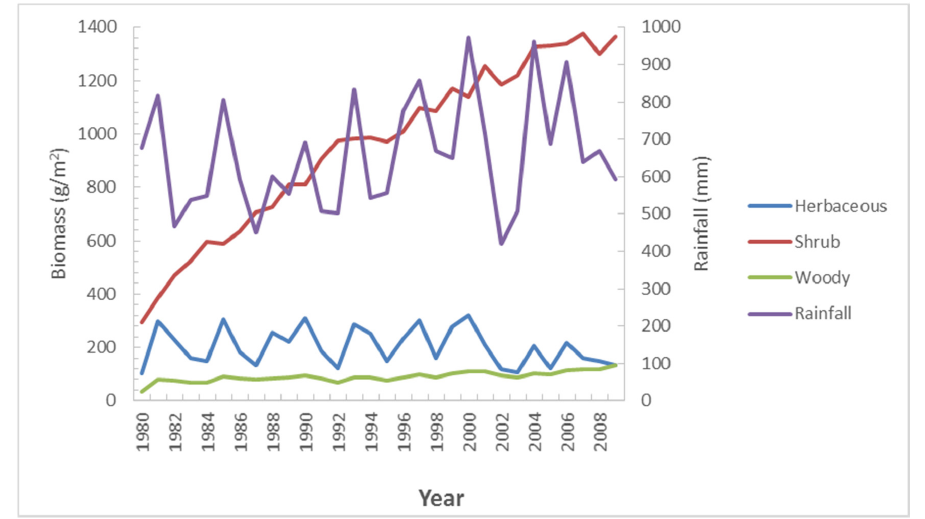
Figure 7. Trends in peak biomass production (g/m 2 ) over a period of 30 years (Historic scenario without climate change effects).